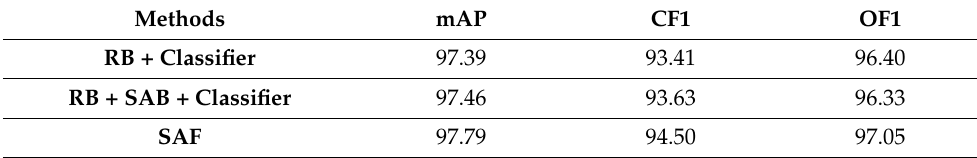
Table 1. Results of key techniques in mAP, CF1 and OF1 (%) on waste bottle dataset.